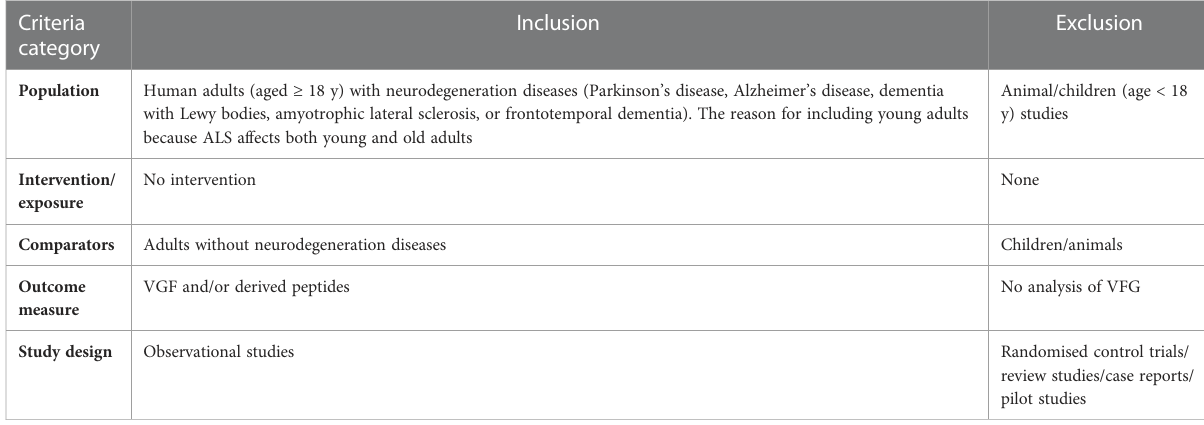
TABLE 2 Population – intervention – comparison – outcome (PICOS) criteria for study inclusion and exclusion. Criteria